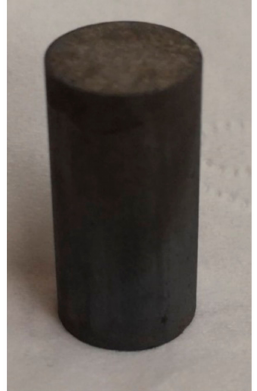
Figure 1. Sample of common cylindrical specimen.